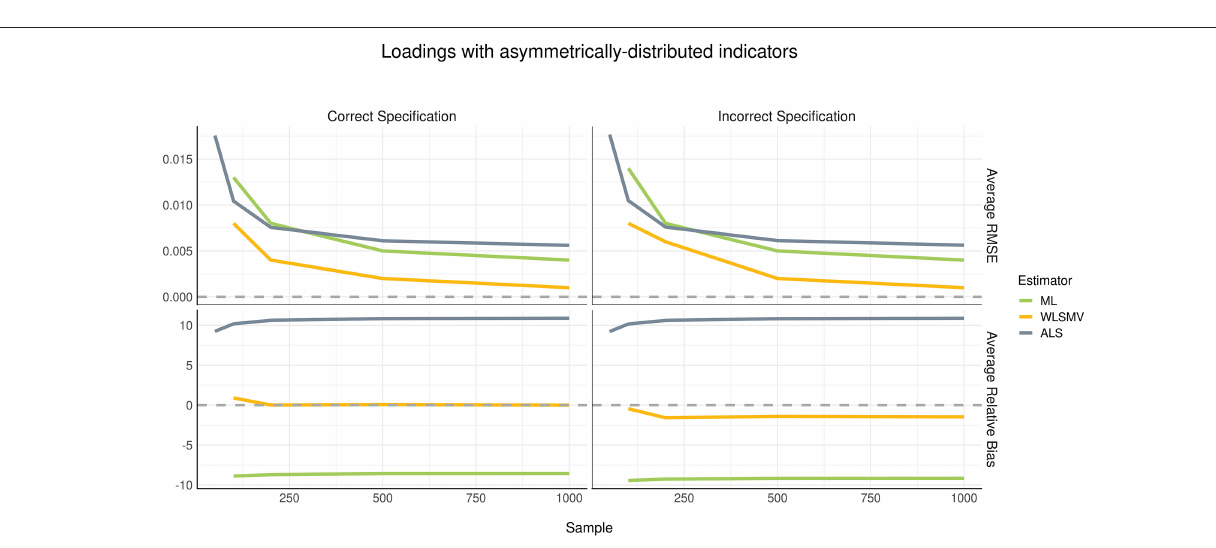
FIGURE 3 | Estimation error and bias in loadings with asymmetrically distributed